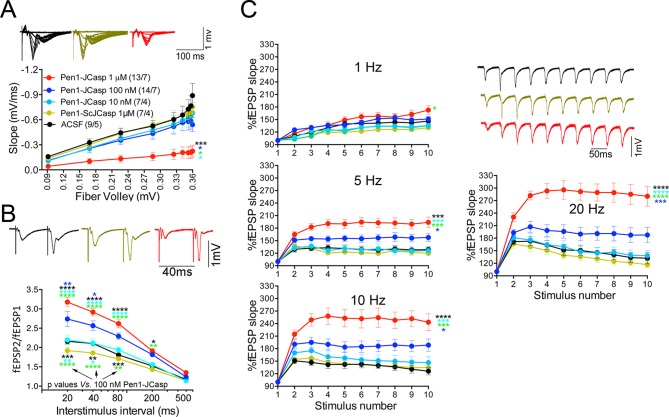
Pen1-JCasp impairs synaptic plasticity.(A) CA1 recordings of hippocampal slices incubated with either artificial cerebrospinal fluid (ACSF), 1 μM Pen1-ScJCasp or Pen1-JCasp at the indicated concentrations. The synaptic input/output (I/O) relationship was obtained by plotting the fiber volley amplitude against the initial slope of the evoked field excitatory postsynaptic potential (fEPSP). Representative traces are shown on top. The slope values of I/O recording for each group were compared for statistical assessments. It has been found that 1 μM Pen1-JCasp significantly reduces synaptic transmission as compared to ACSF (*), Pen1-ScJCasp (*), 10 nM (*), and 100 nM Pen1-JCasp (*p). Representative traces are shown. (B) Average paired-pulse facilitation (PPF) (2nd fEPSP/1st fEPSP) plotted as a function of the inter-stimulus interval. Representative traces of fEPSPs evoked at 40 ms inter-stimulus interval are shown. Pen1-JCasp increases PPF. (C) Synaptic facilitation elicited by stimulus trains at 1, 5, 10, and 20 Hz. fEPSP slopes are normalized to the slope of the first fEPSP of the stimulus train. Representative traces of fEPSPs evoked at 20 Hz are shown. Stimulus artifacts are removed for clarity. Pen1-JCasp increases frequency facilitation (FF) in a frequency and dose-dependent manner. Statistical assessments were performed by: one-way analysis of variance (ANOVA) followed by Tukey’s multiple comparisons test for slopes of I/O curves; two-way repeated measures (RM) ANOVA followed by Tukey’s multiple comparisons test for PPF and FF (*p < 0.05; **p < 0.01; ***p < 0.001; ****p < 0.0001). In FF, 10 nM Pen1-JCasp increased facilitation in a statistically significant manner only at the 10th stimulation (indicated with (*) and (*)). The number of recordings and the number of mice analyzed for each group are shown in (C). All data represent means ± SEM. The complete statistical analyses are shown in the attached Excel file.DOI:
http://dx.doi.org/10.7554/eLife.09743.00610.7554/eLife.09743.007Figure 3—source data 1.Source data for statistical analysis of input/output curves in Figure 3A.DOI:
http://dx.doi.org/10.7554/eLife.09743.00710.7554/eLife.09743.008Figure 3—source data 2.Source data for statistical analysis of paired-pulse facilitation in Figure 3B.DOI:
http://dx.doi.org/10.7554/eLife.09743.00810.7554/eLife.09743.009Figure 3—source data 3.Source data for statistical analysis of frequency facilitation at 1 Hz in Figure 3C.DOI:
http://dx.doi.org/10.7554/eLife.09743.00910.7554/eLife.09743.010Figure 3—source data 4.Source data for statistical analysis of frequency facilitation at 5 Hz in Figure 3C.DOI:
http://dx.doi.org/10.7554/eLife.09743.01010.7554/eLife.09743.011Figure 3—source data 5.Source data for statistical analysis of frequency facilitation at 10 Hz in Figure 3C.DOI:
http://dx.doi.org/10.7554/eLife.09743.01110.7554/eLife.09743.012Figure 3—source data 6.Source data for statistical analysis of frequency facilitation at 20 Hz in Figure 3C.